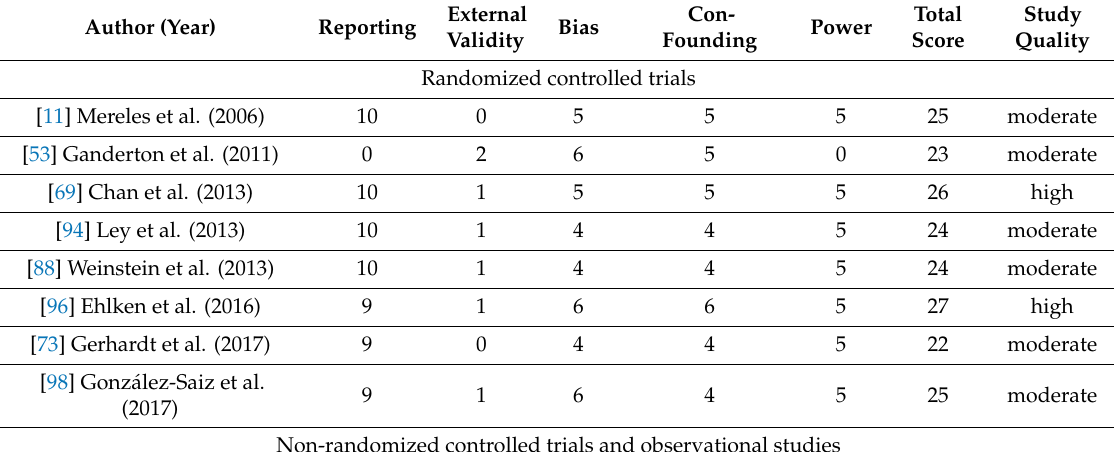
Table 9. Summary of quality assessment in human studies ( n =